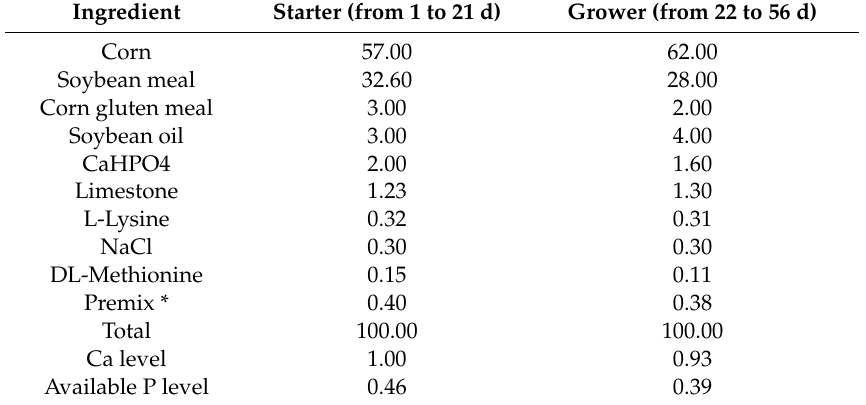
Table 8. Ingredient compositions and the nutrient levels of elemental diets (dry matter basis, %).